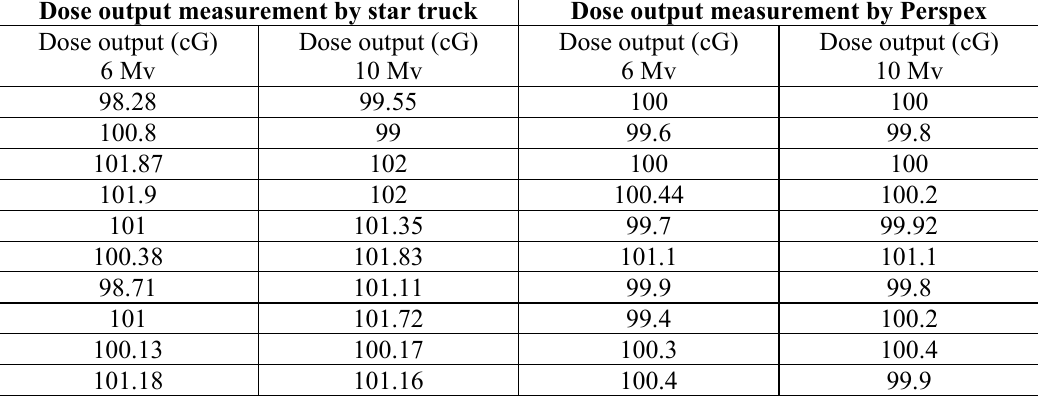
Table 2: Compare between dose output measurements by star truck and Perspex. Dose output measurement by star